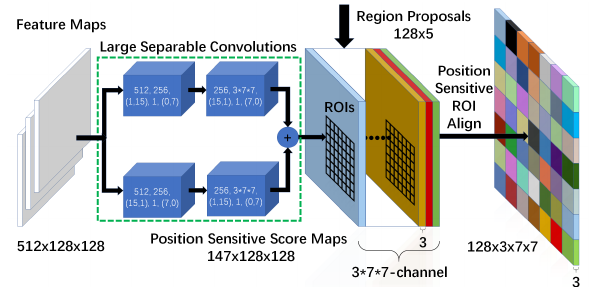
Figure 3. The specific architecture of the Large Separable Convolution and Position-Sensitive RoIAlign blocks in Fig. 2.